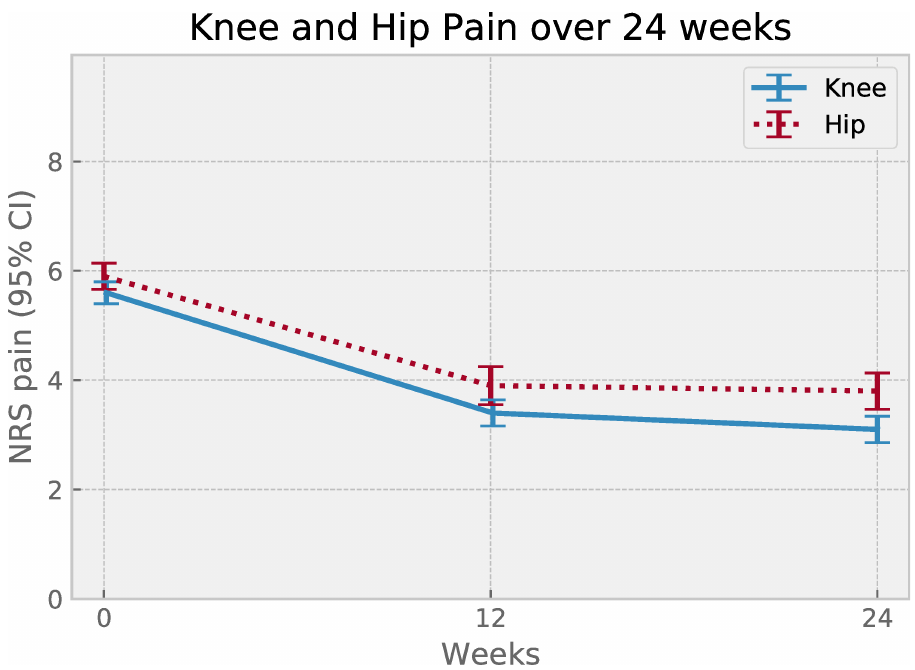
Fig 2. Pain change over time, per index joint, for the 0 to 24-week subgroup of patients. Symbols show mean pain value at 0, 12 and 24 weeks for patient subgroups with index joint knee (n = 301) or hip (n = 198). Error bars represent 95% confidence